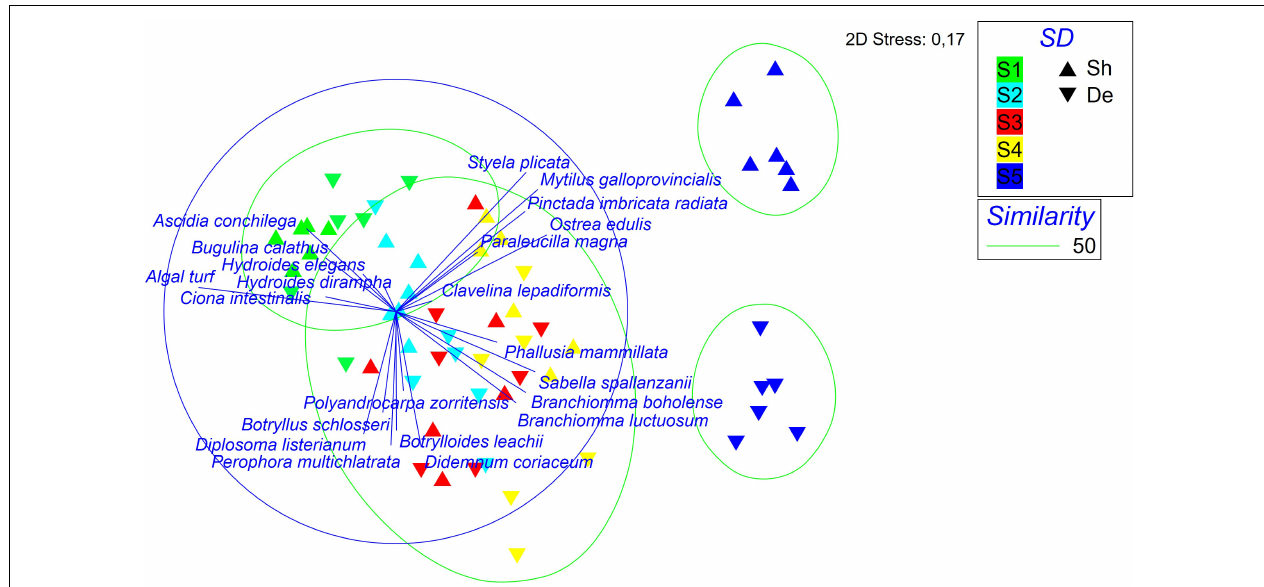
FIGURE 3 | Non-metric multidimensional scaling (nMDS) plot of macrofouling assemblage developed on vertical collectors at different sampling time and depths. S1 = December 2018, S2 = February 2019; S3 = March 2019; S4 = April 2019; S5 = June 2019; Sh = shallow samples, De = deep samples.